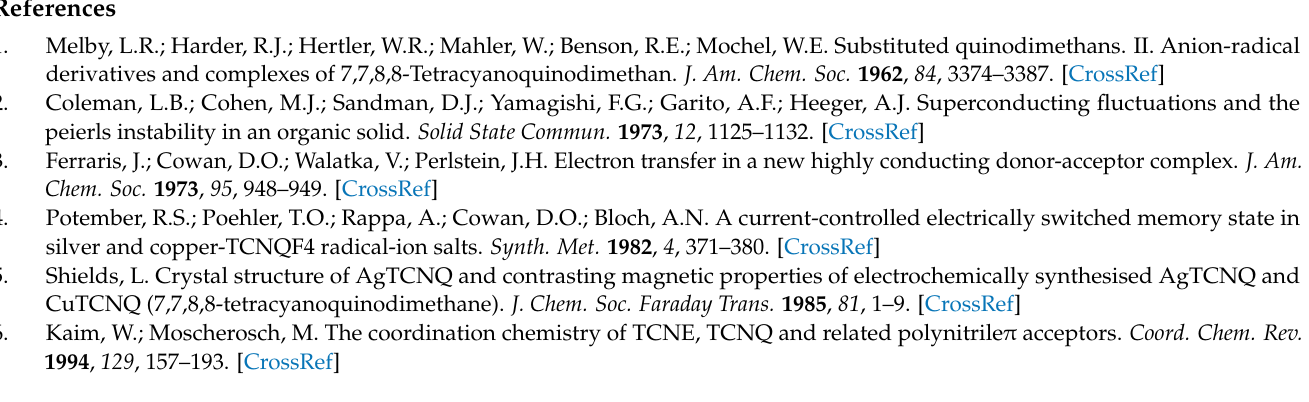
of CuTCNQ, Figure S3: Digital images of the solutions during CuTCNQ synthesis in DMSO. (a) 5 mM TCNQ solution before exposure to Cu foil, and (b) represents the same solution after the reaction, Figure S4: Low magnification SEM images of CuTCNQ grown on Cu foil using (a) 1 mM, (b) 2.5 mM and (c) 5 mM TCNQ in DMSO with increasing concentration of water (0, 5, 15, 30%), Figure S5: CuTCNQ crystal width with respect to water concentration, Figure S6: EDX mapping of CuTCNQ grown on Cu foil using (a) 1 mM, (b) 2.5 mM and (c) 5 mM TCNQ in DMSO with increasing concentration of water (0, 5, 15, 30%). Red colour corresponds to carbon while green colour indicates nitrogen, both arising from the TCNQ component of CuTCNQ. EDX maps reveal homogeneous distribution of CuTCNQ structures on Cu foil, particularly when higher concentrations of TCNQ 0 and water are employed during synthesis, Figure S7: UV-Vis absorbance spectra of TCNQ 0 obtained from (a) 1 mM (b) 2.5 mM and (c) 5 mM TCNQ 0 in 0, 5, 15 and 30% v/v H 2 O in water/DMSO bisolvent solution before and after the reaction with Cu foil, Figure S8: Water contact angle images of CuTCNQ on Cu foil with respective SEM images (a) 1 mM, (b) 2.5 mM and (c) 5 mM TCNQ in DMSO with increasing concentration of water (0, 5, 15, 30%). The scale bar is 50 µ m, Figure S9: UV-visible absorbance spectra representing the time-dependent catalytic reduction of 1 mM ferricyanide in the presence of excess thiosulfate ions by CuTCNQ fabricated using 5 mM TCNQ 0 in the presence of (a) 0%, (b) 5%, (c) 15% and (d) 30% v/v H 2 O in a water/DMSO bisolvent system, Figure S10: FTIR spectra of CuTCNQ catalysts prepared using 5 mM TCNQ concentration and different v/v water/DMSO concentrations, as acquired after the catalysis